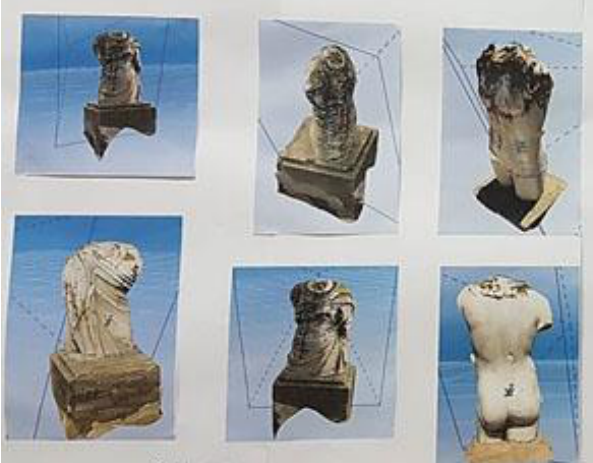
Figure 8- Photomodeling of statues of the villa of the aviary using 123 D Catch by autodesk.